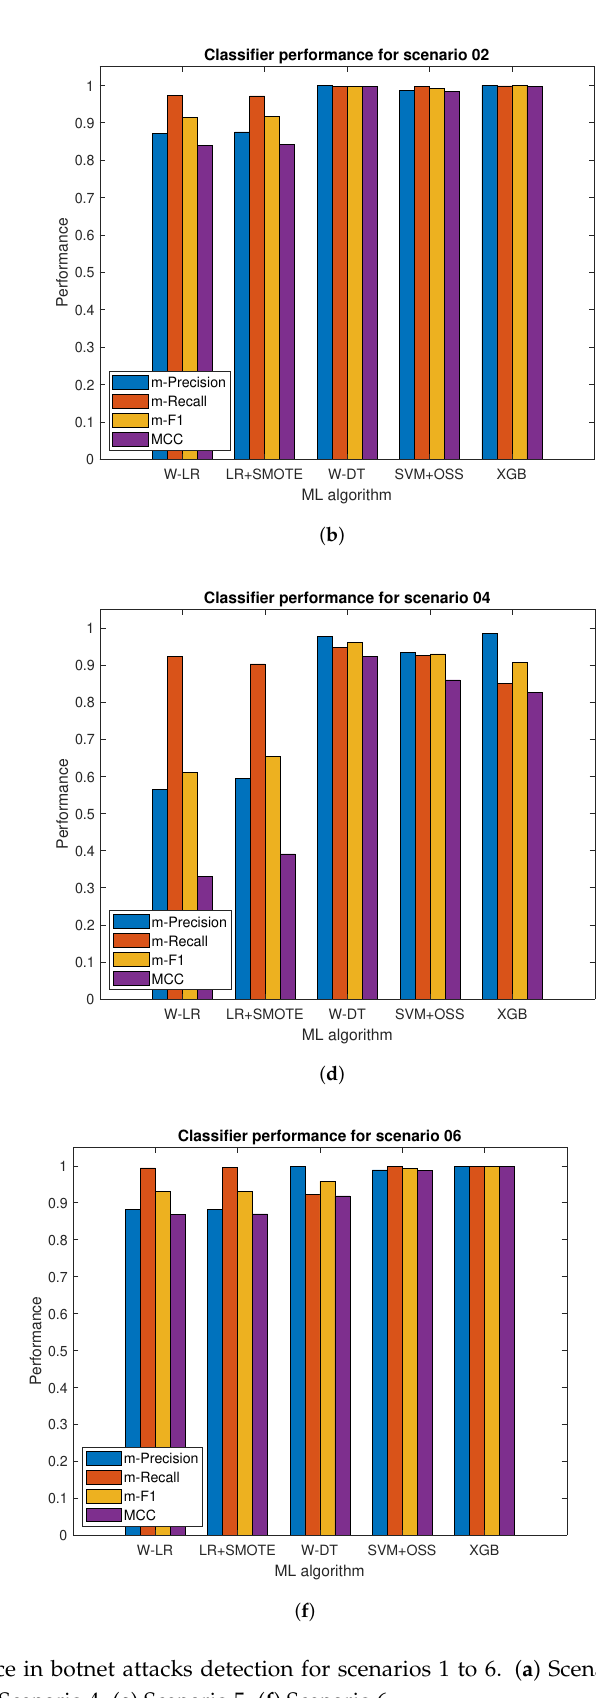
Figure 5. Classifiers performance in botnet attacks detection for scenarios 1 to 6. ( a ) Scenario 1. ( b ) Scenario 2. ( c ) Scenario 3. ( d ) Scenario 4. ( e ) Scenario 5. ( f ) Scenario